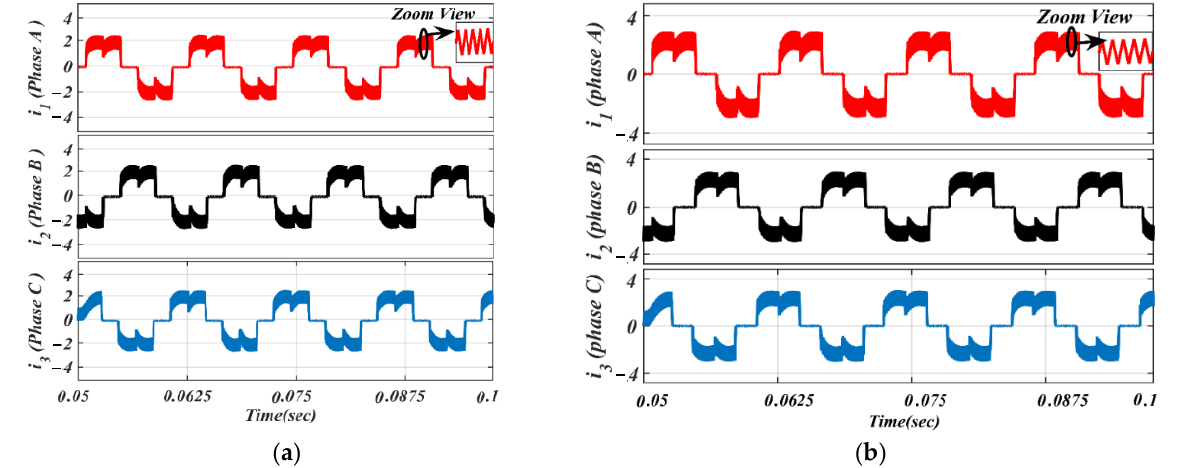
Figure 10. Simulated phase currents of the classical BLDCM drive: ( a ) lightly loaded or partially loaded (40% of maximum load); and ( b ) full load (85% of maximum load).